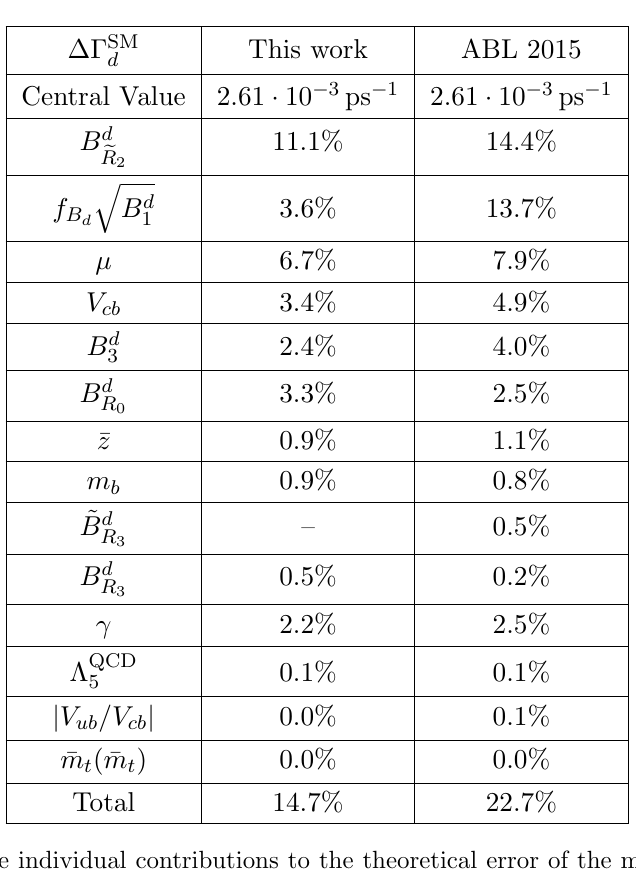
( M W ) and (cid:1) C s;cc ( M W ) allowed 1 2